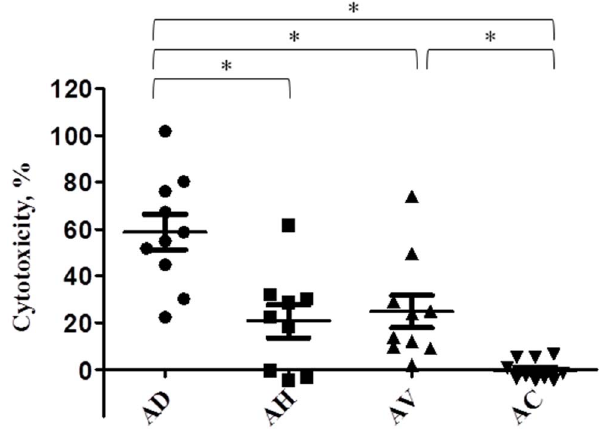
Characteristics